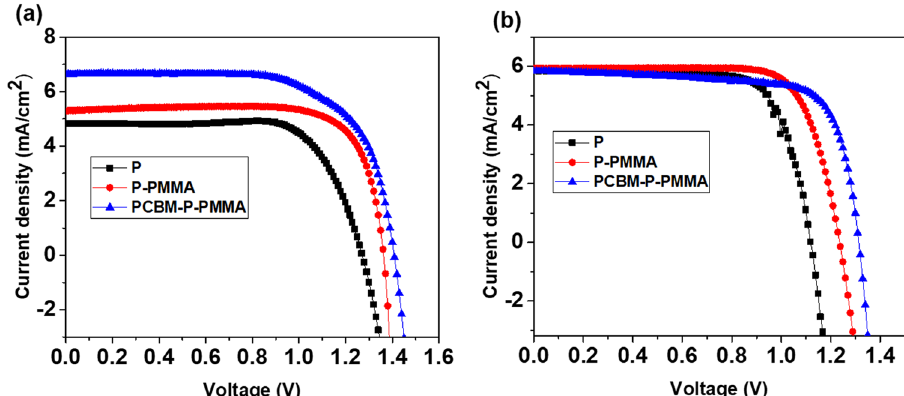
Figure 6. Current density–voltage curves of devices with and without PMMA and PCBM passivation layers, made by ( a ) the anti- solvent method and ( b ) FIRA-annealing. The scan rate was 20 mV s −1 .